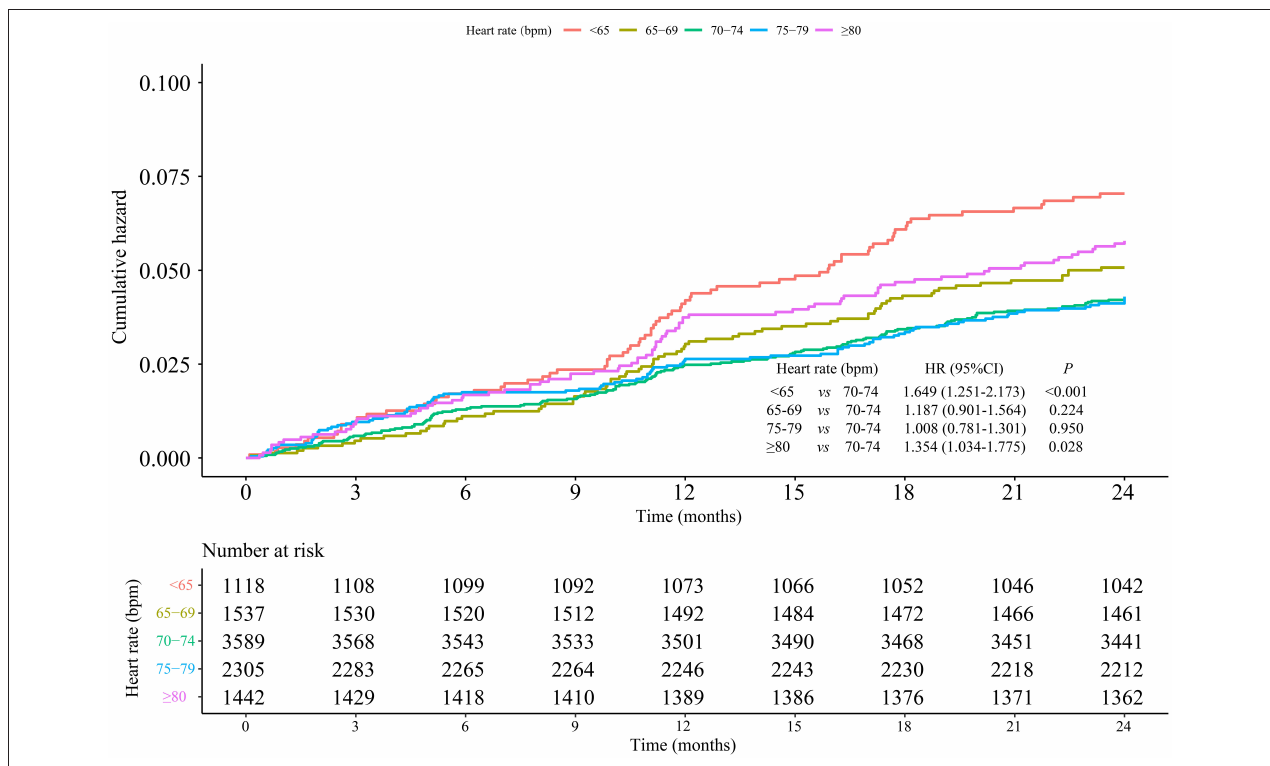
FIGURE 2 | Cumulative incidence of MACEs in different groups of heart rate.